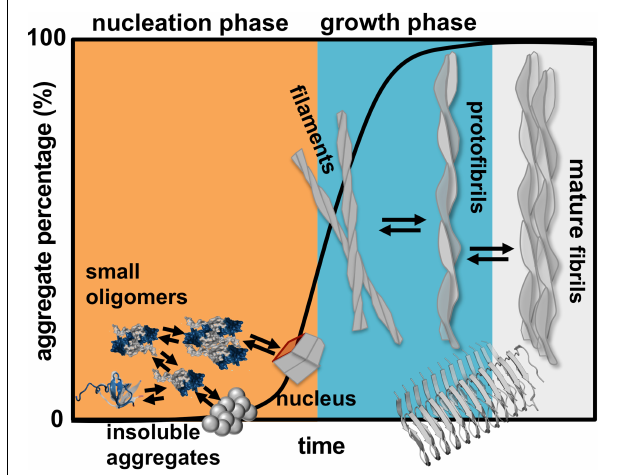
FIGURE 1 | Schematics of protein aggregation. Representation of the process of protein aggregation as a function of time, starting from aggregation prone monomers till the formation of mature amyloid fibrils. This article focus on the nucleation phase, whereby small oligomers (dimers, trimers, tetramers etc.) form prior to the establishment of an aggregation nucleus that triggers the growth phase leading to fibrils.